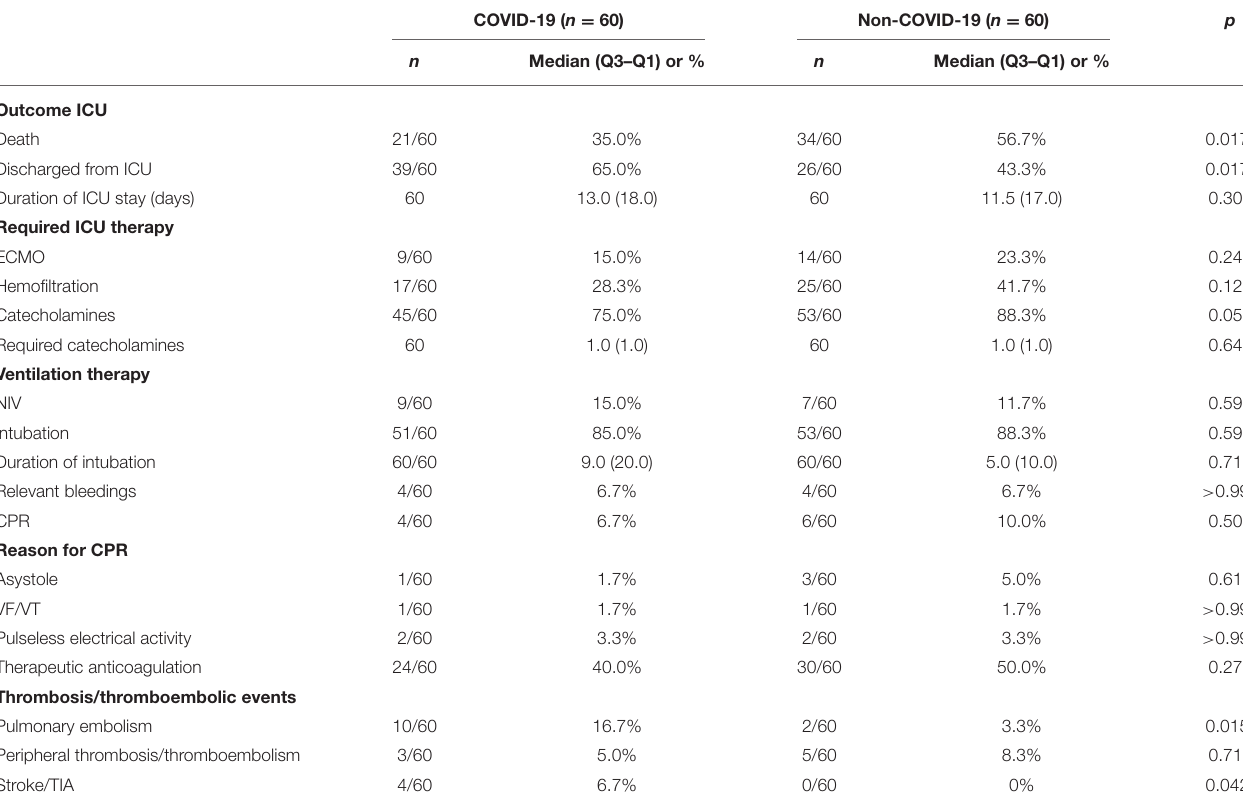
TABLE 3 | Patients’ outcome and relevant therapies during ICU